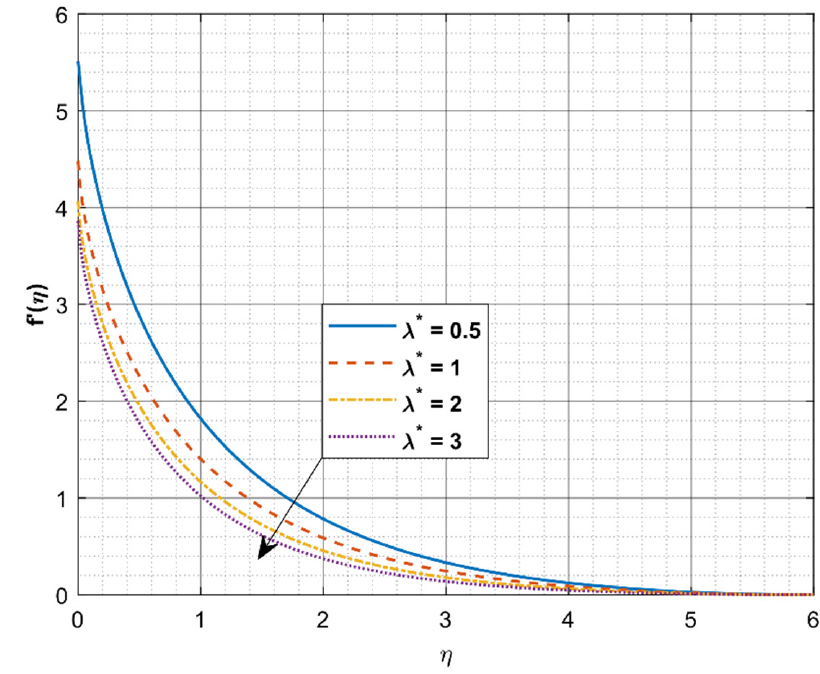
Figure 4. Influence of λ ∗ on f (cid:48) ( η ) .